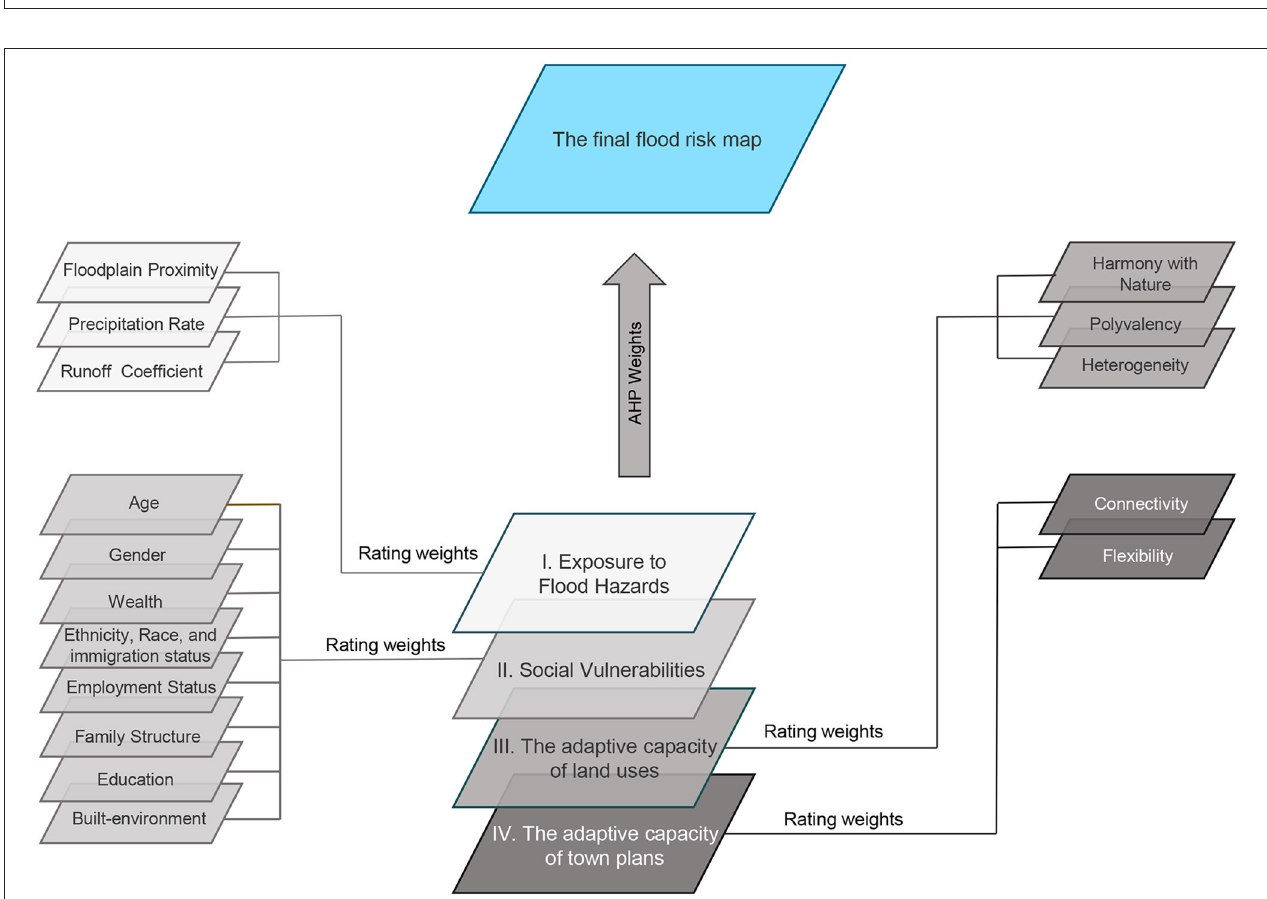
FIGURE 3 | A schematic diagram showing the overlay analysis process.